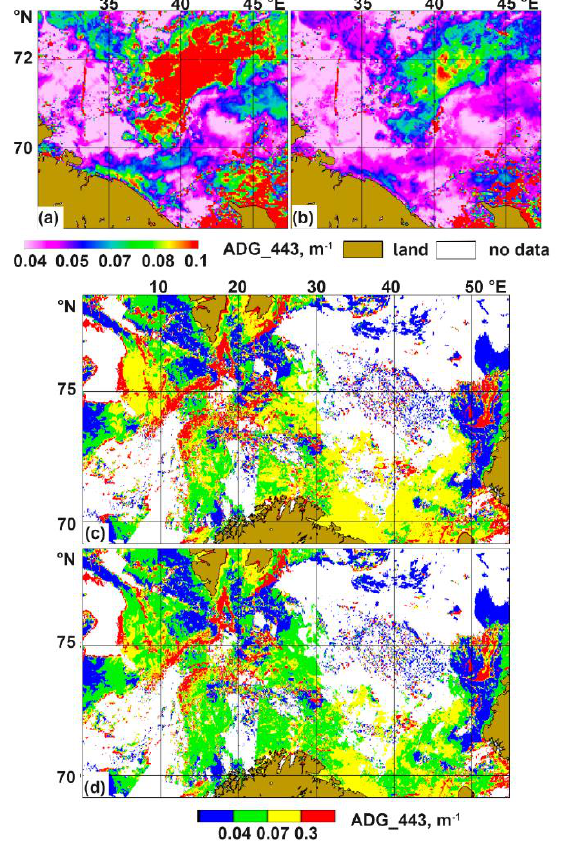
Figure 6. The ADG_443_NN distributions based on standard OLCI data a g _olci_std ( a , c ) and corrected ag_corr data ( b , d ) for the AMK-65 ( a , b ) and AMK-68 ( c , d ) cruises.